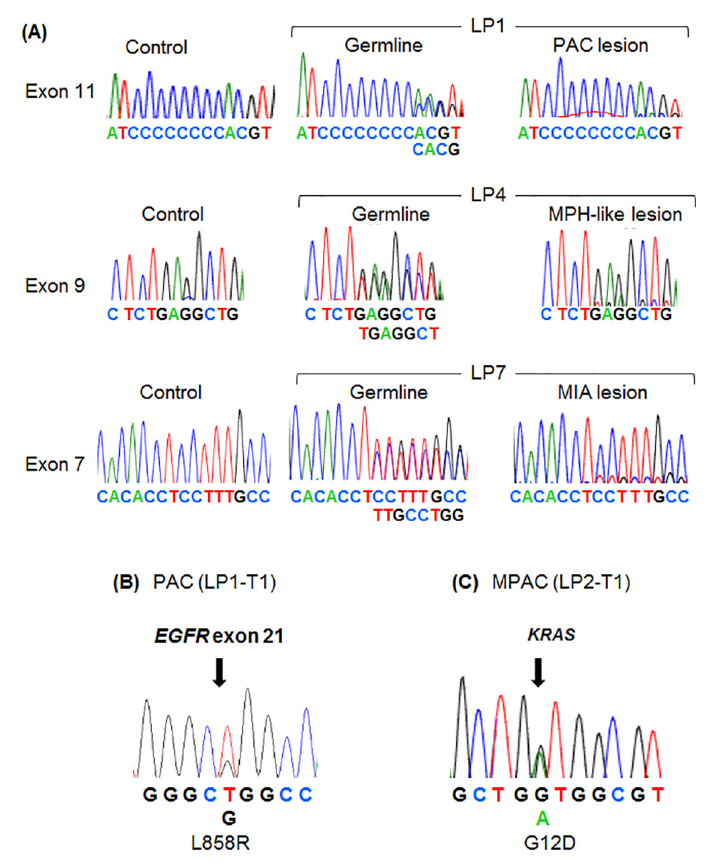
Fig 4. Sequence analysis of FLCN , EGFR , and KRAS in BHD lung neoplasms. (A) Germline and somatic FLCN status in 3 representative cases with different mutation patterns are shown. Control normal sequences are shown on the left. Germline mutations are shown on the middle. The somatic status of FLCN in microdissected neoplasms are shown on the right. (B) The papillary adenocarcinoma (PAC) had a heterozygous missense mutation (L858R) in EGFR (indicated by an arrow). (C) The micropapillary adenocarcinoma (MPAC) had a heterozygous missense mutation (G12D) in KRAS (right, indicated by an